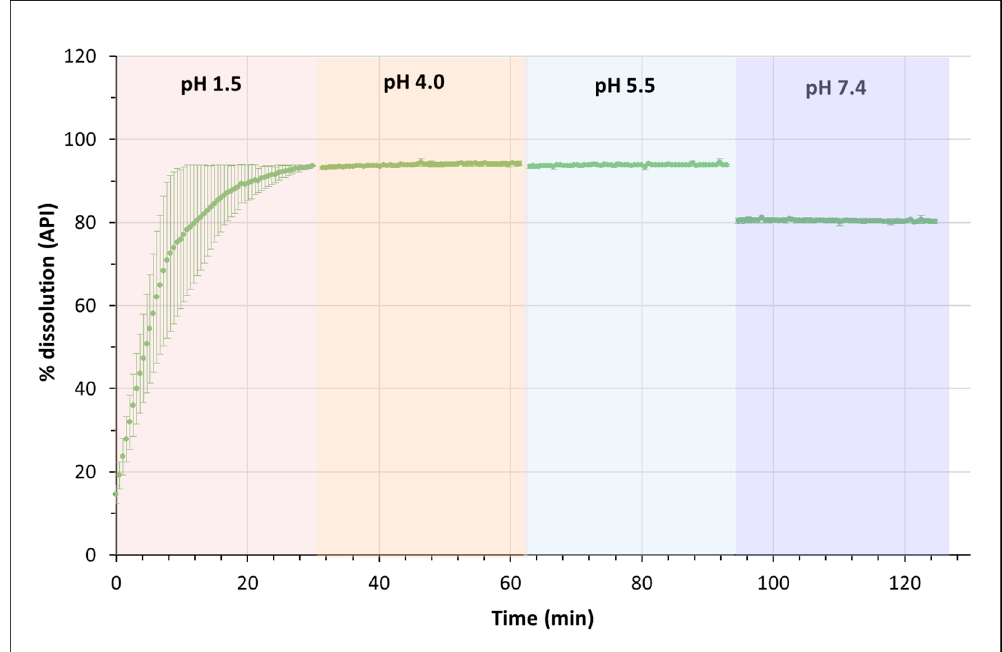
Figure 6. Dissolution profile of the Norfloxacin–resorcinol cocrystal in a 4-sector pH